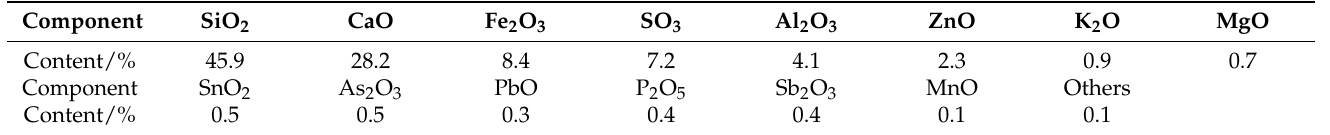
Table 4. Chemical components of Tongkeng ore.